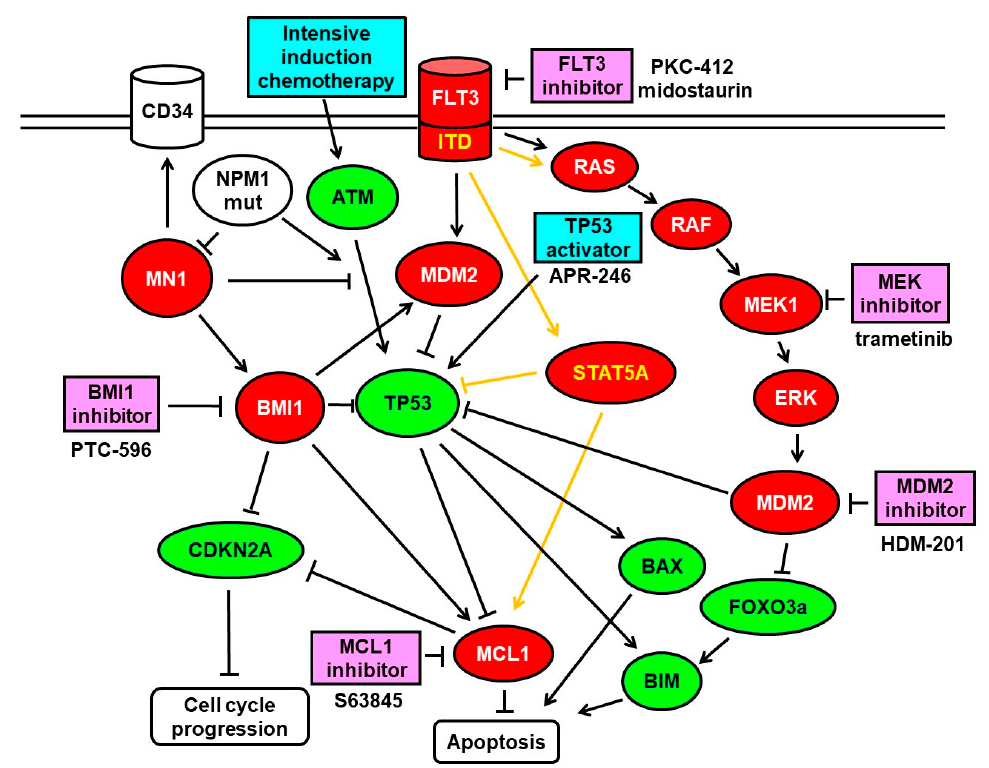
Figure 2. Schematic representation of the FLT3-ITD signaling pathways and downstream effects. FLT3-ITD is a constitutively active growth factor receptor signaling via PI3K-AKT, via RAS-MEK-ERK, and via STAT5 leading to cell growth and proliferation via p53 inhibition and MCL1 induction. p53 function can be reactivated by APR-246 treatment leading to inhibition of MCL1 gene expression. MCL1 function can be inhibited by S63845, by PTC596 via BMI1 inhibition, and by APR-246 via p53 induction. Oncogenic functions are indicated in red, tumor suppressor functions in green, chemical inhibitors in pink, chemical activators in blue.